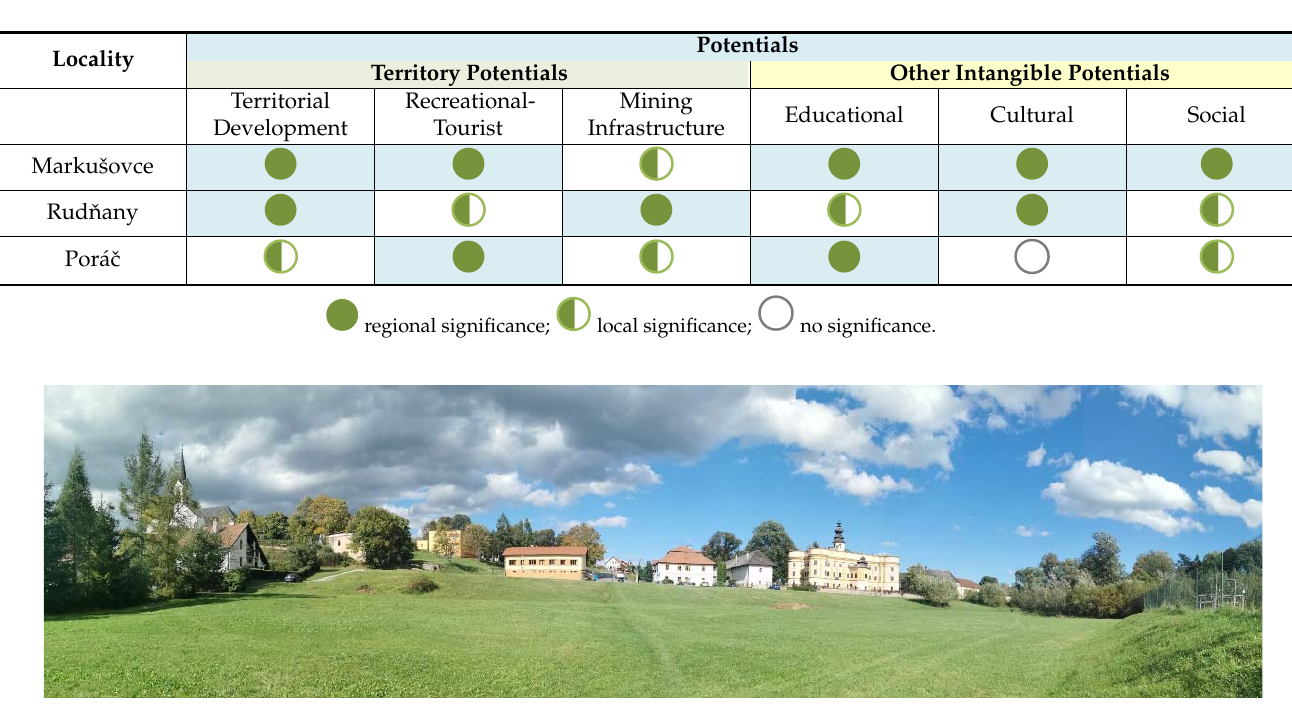
Figure 6. Technical mining equipment, Porá č (photo of the authors). Figure 7. Mining artifact, Markušovce (photo Záveská, K.). At this stage of the research, a combination of several participatory method tools was used to measure respondents’ attitudes. A questionnaire that was understandable to the public was designed to facilitate clear responses with the prerequisite of being transformed into a case study. Today, citizens often want to apply their ideas to the environment, with the public proving to be the most influential factor in creating the environment [22]. The most commonly used methods of measuring attitudes include the Likert scale, which helps respondents to express an opinion measurable on a scale. To select the respondents—the research sample, a so-called available sample was used. The